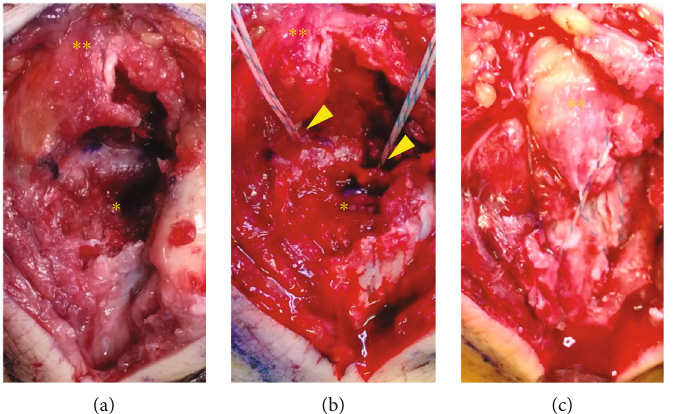
Figure 2: Intraoperative images of the left elbow. The triceps brachii tendon (double asterisk) is continuous with the fracture fragment (asterisk) (a). Two suture anchors (arrowheads) were inserted into the ulna proximal to the fracture site (b). After passing the suture thread through the triceps brachii tendon, the fracture fragments and triceps were reduced and fi xed together using the suture bridge technique